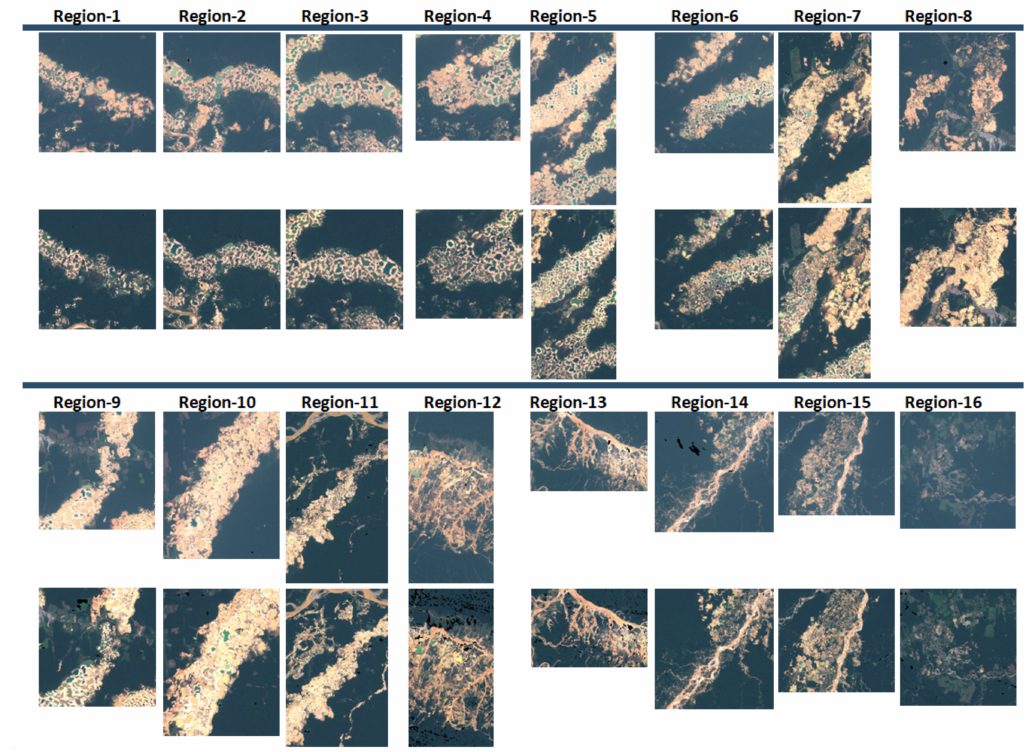
Figure A1. All images in MDD were used for LoRo experiments.